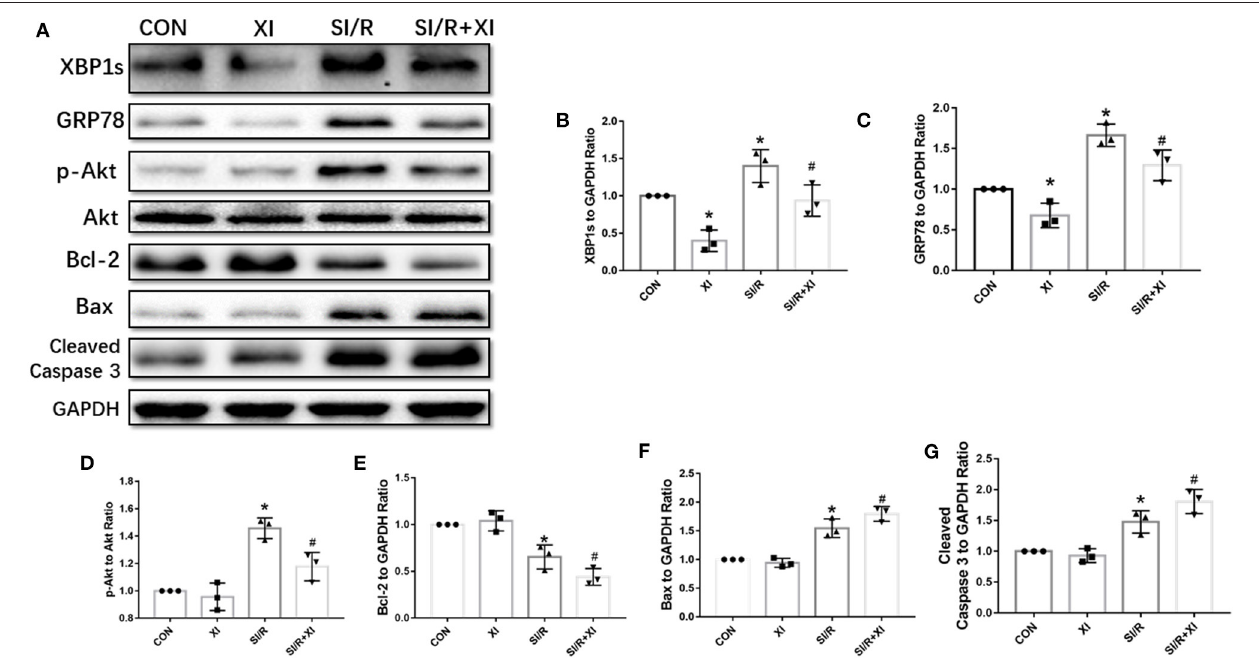
FIGURE 6 | 4 µ 8C inhibited XBP1/GRP78/Akt pathway and enhanced apoptotic protein expressions in vitro . (A) Representative blot images of proteins related to XBP1/GRP78/Akt and apoptotic signaling pathways in H9c2 cells. (B–G) The quantitative analysis of XBP1, GRP78, p-Akt, Bcl-2, Bax, and cleaved Caspase 3 protein expressions. n = 3 in each group. * P < 0.05 vs. CON group, # P < 0.05 vs. SI/R group.